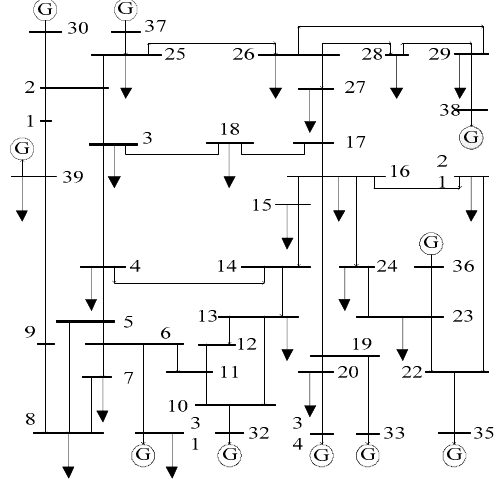
Figure 4. IEEE 10-machine 39-node system.